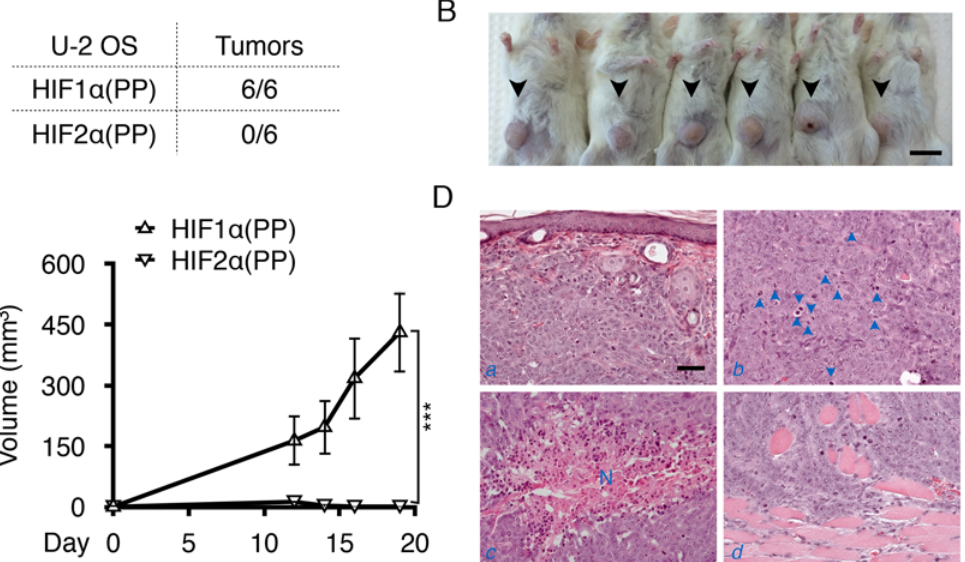
Fig 3. U-2 OS cells acquired tumorigenicity after intermittent induction of HIF1 α (PP). (A) Tumor incidence is shown in 6 NSG mice after bilateral, subcutaneous injections of the 8-week HIF1 α (PP) and HIF2 α (PP) cells. (B) Only injections of the HIF1 α (PP) cells produced tumors, as indicated by arrowheads. Scale bar, 1 cm. (C) Tumor volume was calculated based on measurements and plotted as a function of time. *** , p -value < 0.001. (D) Hematoxylin and eosin staining of the tumor specimens reveals invasion of the dermal layer ( a ), numerous mitoses (arrowheads) ( b ), necrosis (N) ( c ), and invasion into the striated muscle layer ( d ). Scale bar, 100 μ